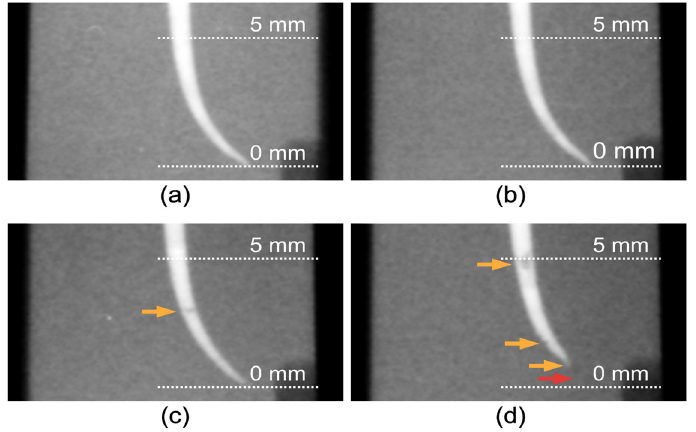
Figure 4. Representative radiographs from each group showing the apical 5 mm: ( a ) Lawaty group; ( b ) auger group; ( c ) GP group; and ( d ) the plugger group. Orange arrows indicate areas of reduced relative luminescence. The red arrow shows that the obturation is short of working length (also an area of reduced relative luminance).